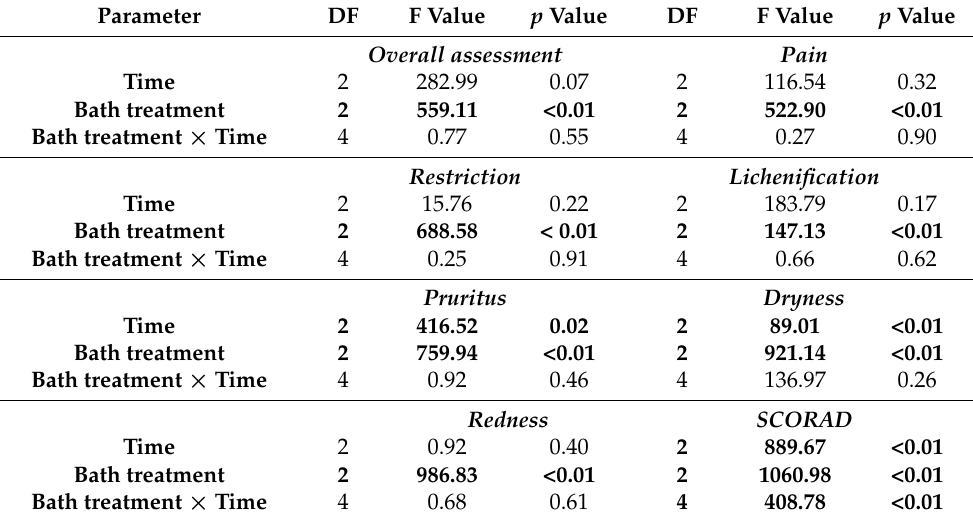
Figure 1. Severity scoring of atopic dermatitis (SCORAD) of atopic dermatitis (AD) patients after daily synbiotic (black bar, n = 7), prebiotic (green bar, n = 8) or placebo bath (cyan bar, n = 7) over time. Error bars indicate standard deviation. Different letters above bars within panels indicate significant differences ( p < 0.05) according to two-way analysis of variance (ANOVA). Table 1. Two-way analysis of variance (ANOVA) of quality of life (QoL) parameters and severity scoring of atopic dermatitis (SCORAD) from AD patients after 14 days of daily synbiotic, prebiotic or placebo bath treatment. Significance of bath treatments, time or the interaction of bath treatments and time is highlighted in bold ( p < 0.05). DF, degree of freedom.